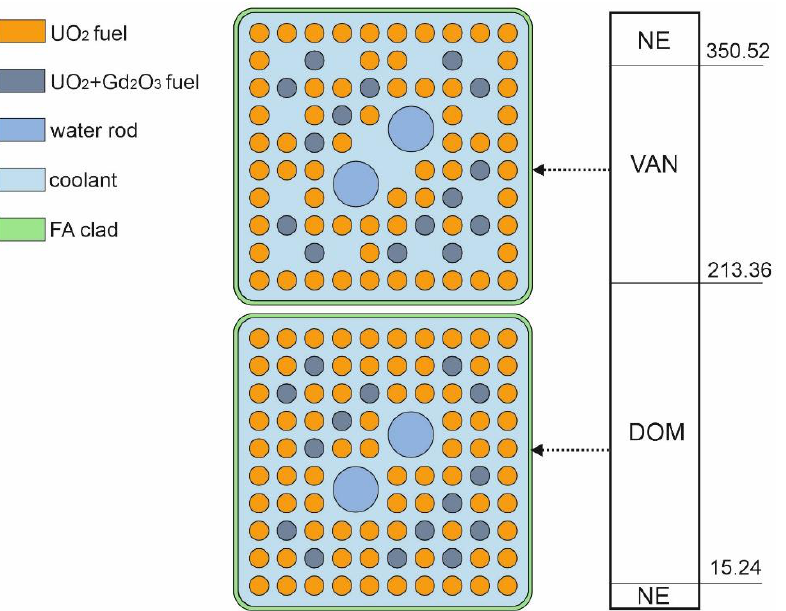
Figure 1. Boiling water reactor (BWR) GE-14 10 × 10 fuel assembly design as used for the study. Table 1. BWR 10 × 10 assembly parameters [26].